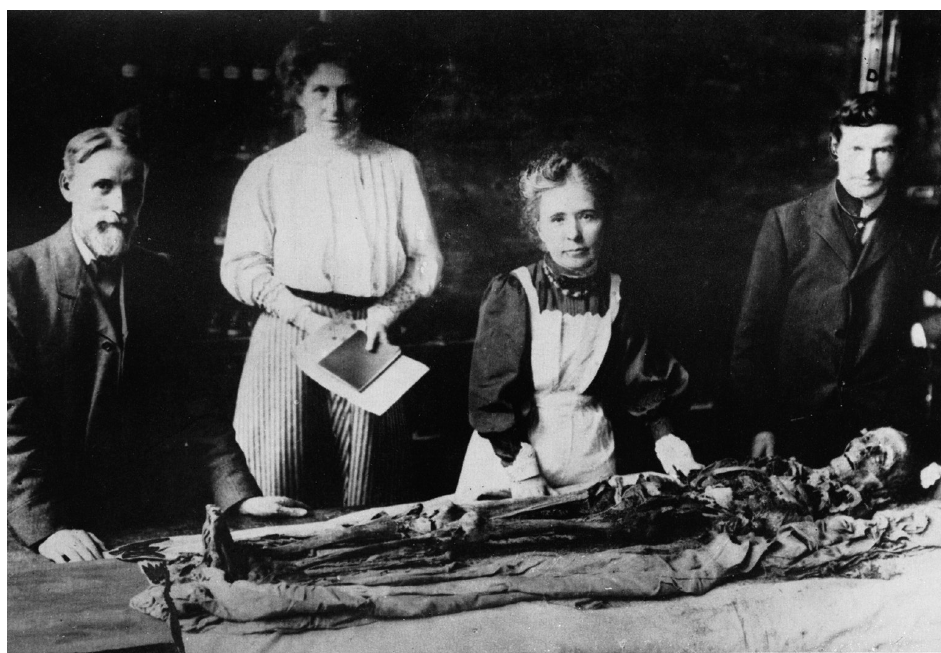
Fig. 2: Margaret Murray (third from left) unwrapping a mummy at the Manchester Univer- sity Museum in 1908. The other people in the picture are (from left to right): Mr Wilfred Jackson, Miss Hart-Davies and Mr Standen (photo: courtesy of Manchester Museum, The University of